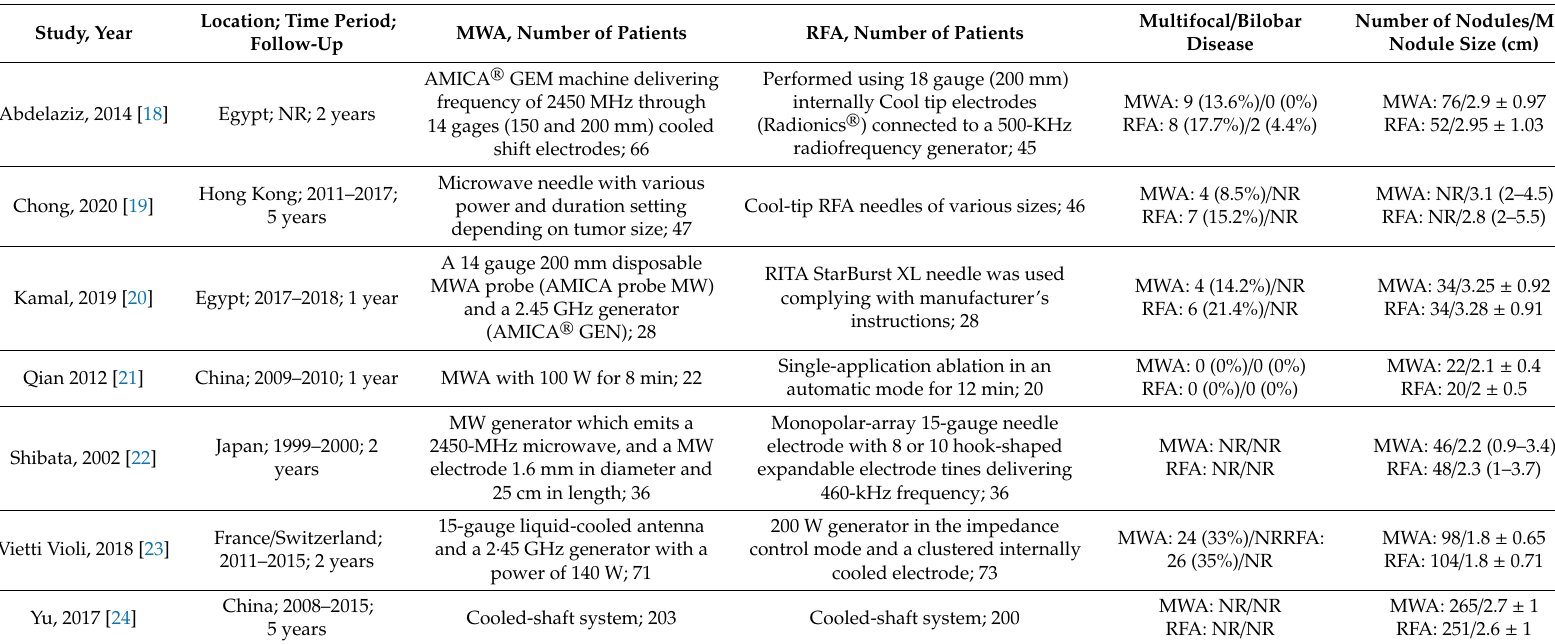
Characteristics of included randomized controlled trials comparing microwave ablation and radiofrequency ablation for the treatment of hepatocellular